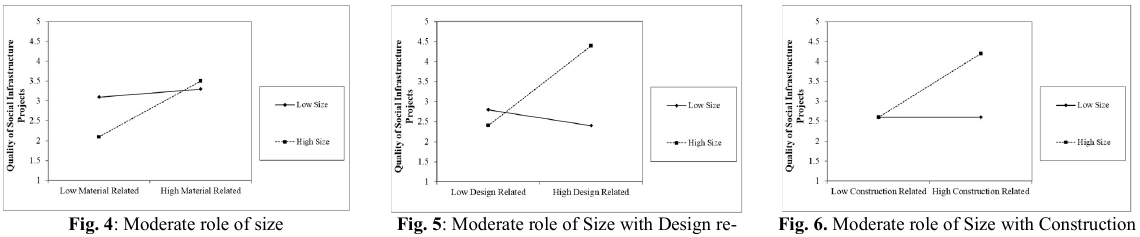
Fig. 4 : Moderate role of size Fig. 5 : Moderate role of Size with Design re-